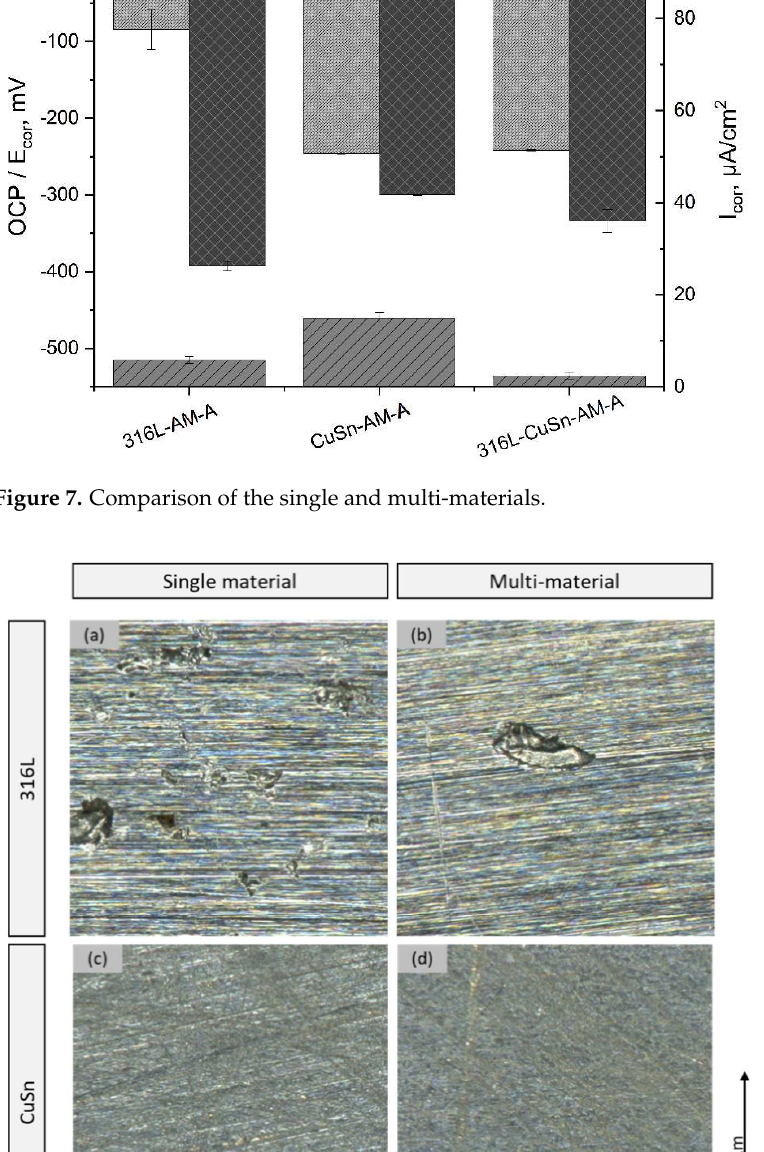
Table 5. LSV characteristic values of single and multi-materials.